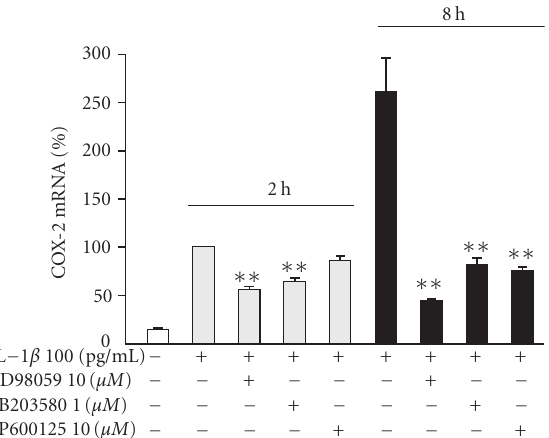
Figure 4. The e ff ects of SP600125, SB203580, and PD98059 on COX-2 mRNA levels in IL-1 β -stimulated human chondrocytes. Human chondrocytes were incubated with IL-1 β (100pg/ml) and with or without SP600125, SB203580, and PD98059. Incu- bations were terminated at the indicated time points, and the extracted total RNA was subjected to real-time RT-PCR. COX-2 mRNA levels were normalized against β -actin mRNA. Mean ± SEM, n = 6, ∗∗ indicates P < . 01 as compared with cells treated with IL-1 β